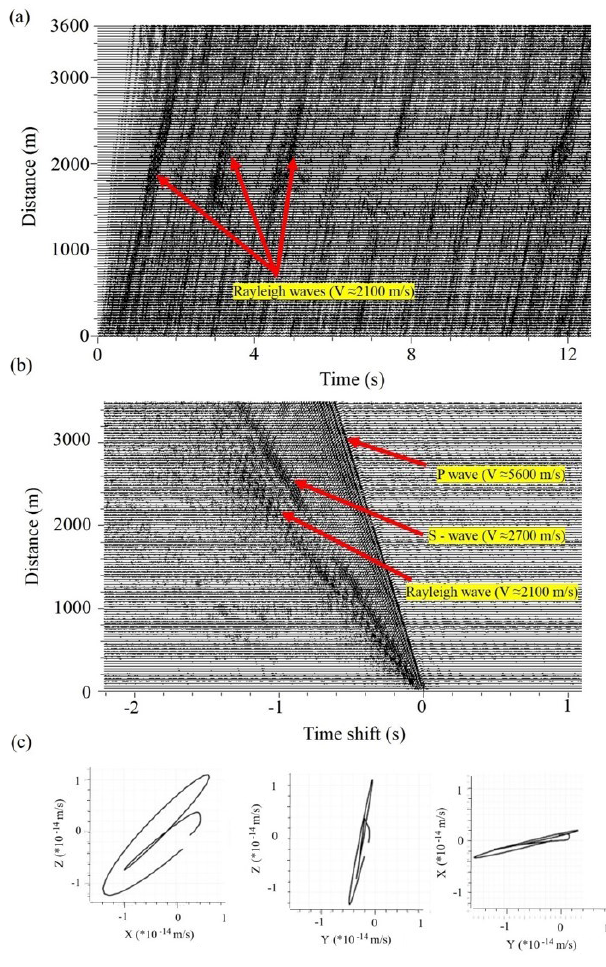
Figure 8. Synthetic seismograms of the signal with the spectrogram presented in Fig. 7 and propagating in the synthetic model shown in Fig. 3. The virtual source is located at an offset of 0m: (a) seis- mograms of vertical components; (b) cross-correlation functions of vertical components, calculated between the first trace and all other traces in panel (a) ; (c) particle motion diagram of Rayleigh wave part in panel (b)